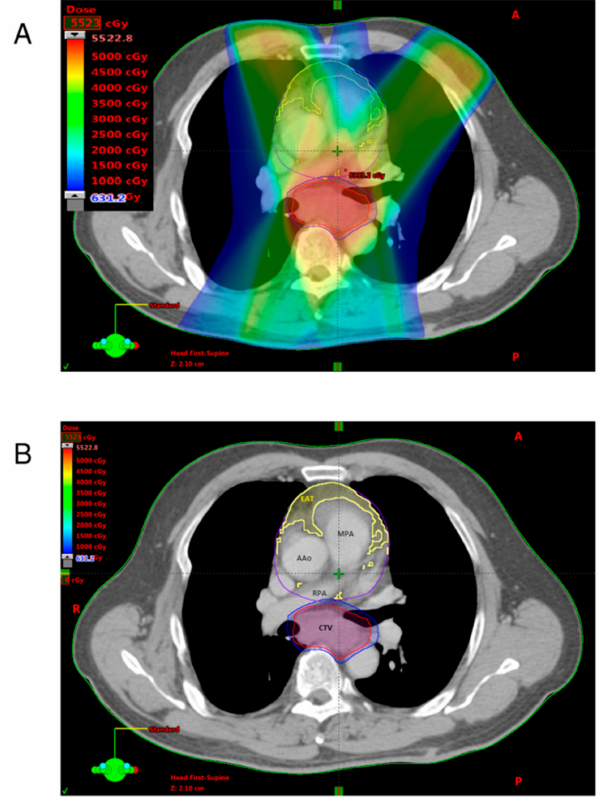
Figure 1. ( A ) The dose distribution was in color wash with IMRT treatment planning; ( B ) the epicardial adipose tissue ( yellow ) was contoured based on the anatomical boundary of heart, ranging from − 195 to − 45 HU. Abbreviations: EAT, epicardial adipose tissue; MPA, main pulmonary artery; AAo, ascending aorta; RPA, right pulmonary artery; CTV, clinical target